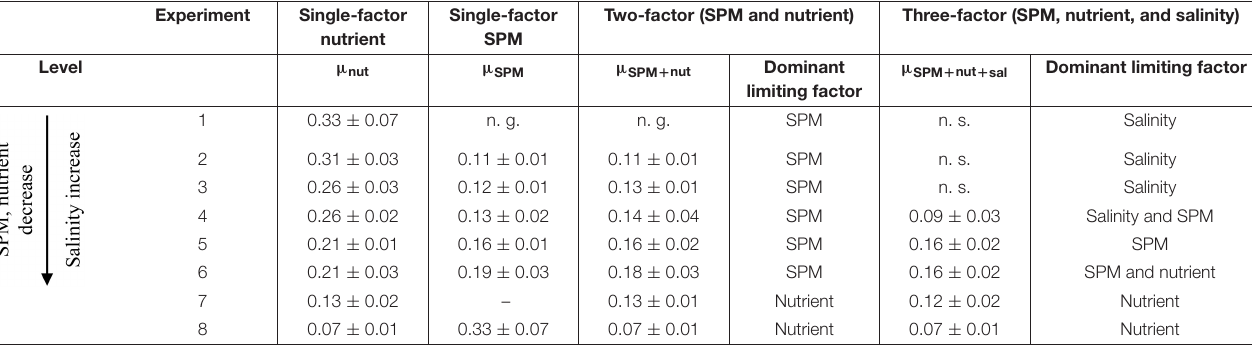
TABLE 3 | Specific growth rates (d − 1 , mean ± standard deviation) of A. carterae under different culture settings and the dominant limiting factors in the two-factor and three-factor